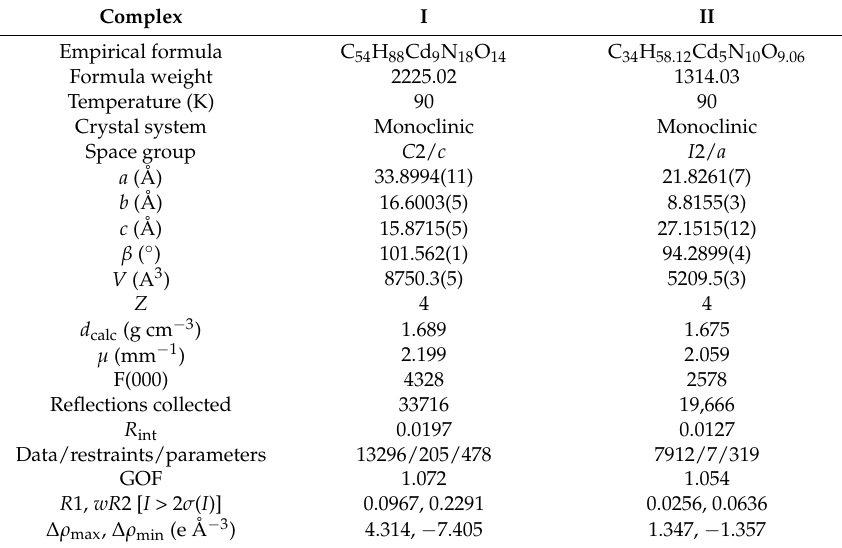
Table 1. The crystal